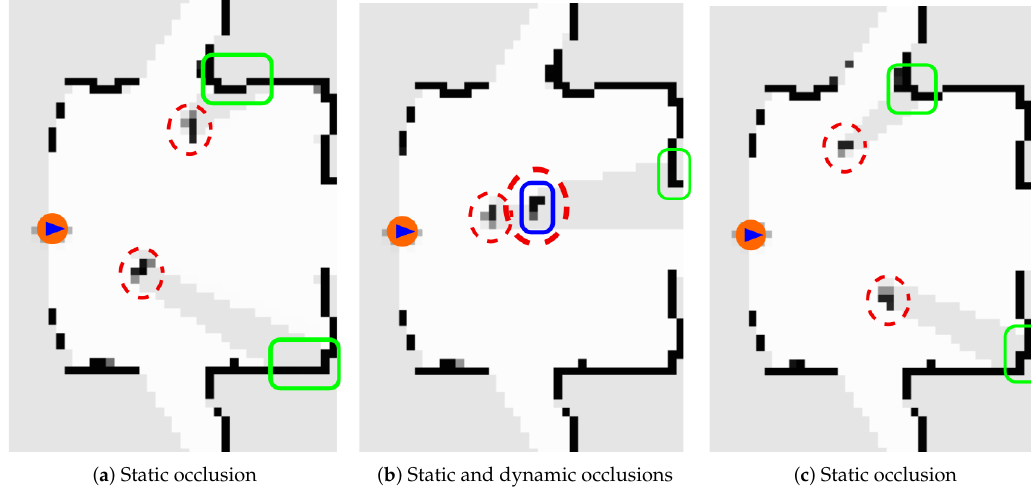
Figure 5. Occlusion Handling: Static and Dynamic